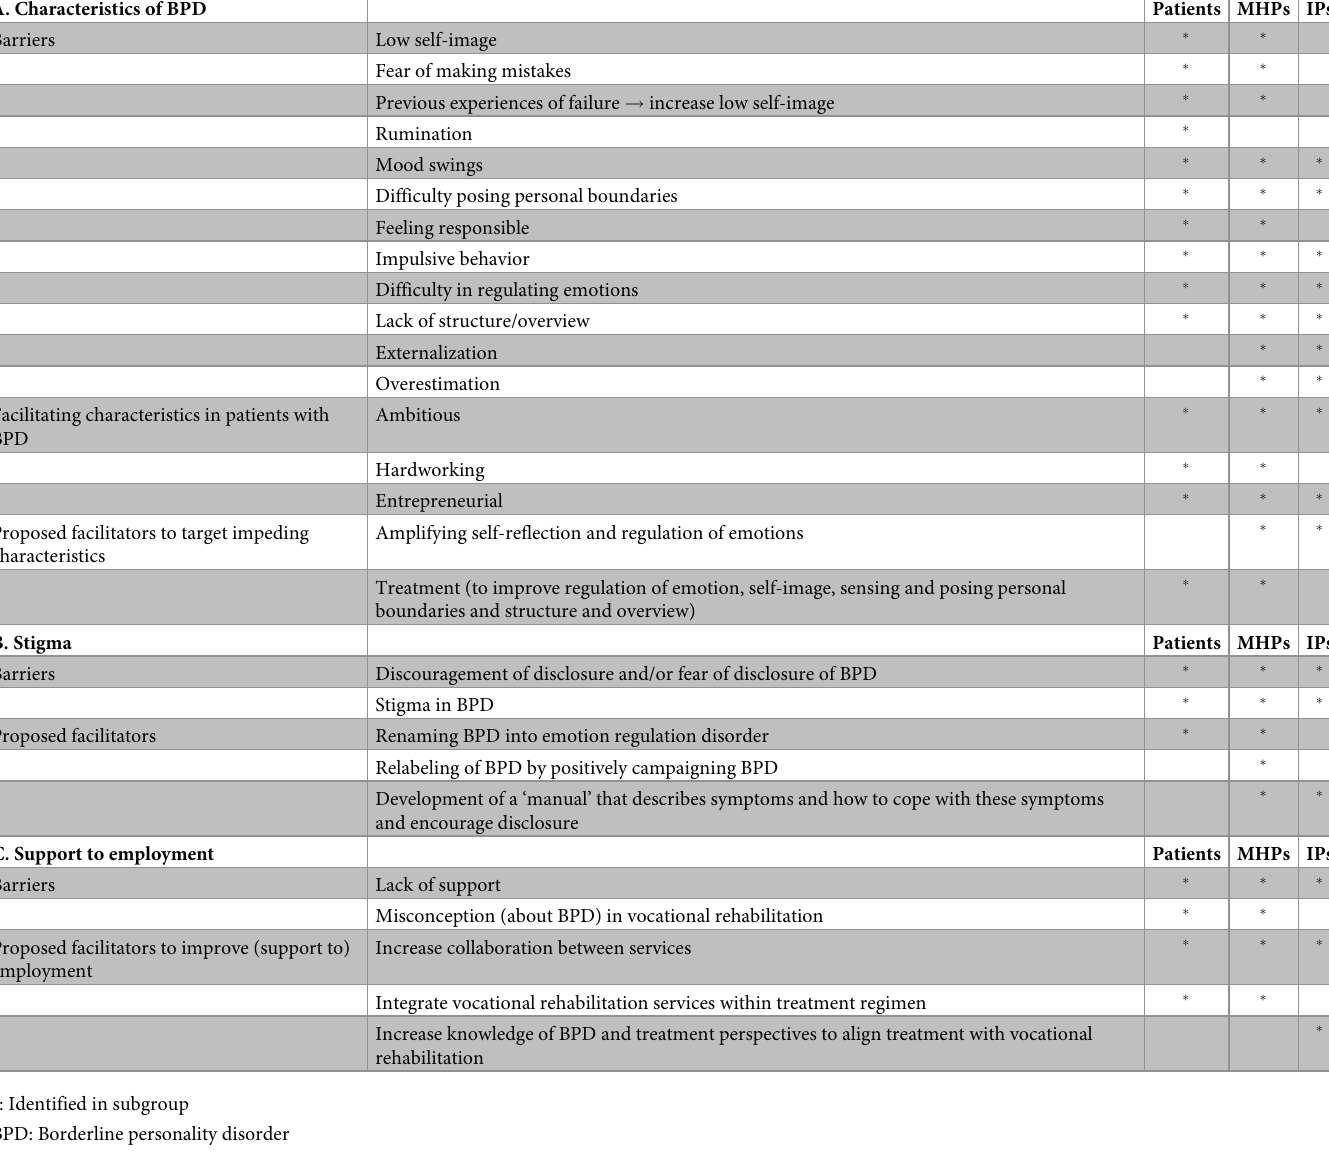
Table 3. Barriers and facilitators to employment in BPD from the perspectives of patients, MHPs and IPs. A. Characteristics of